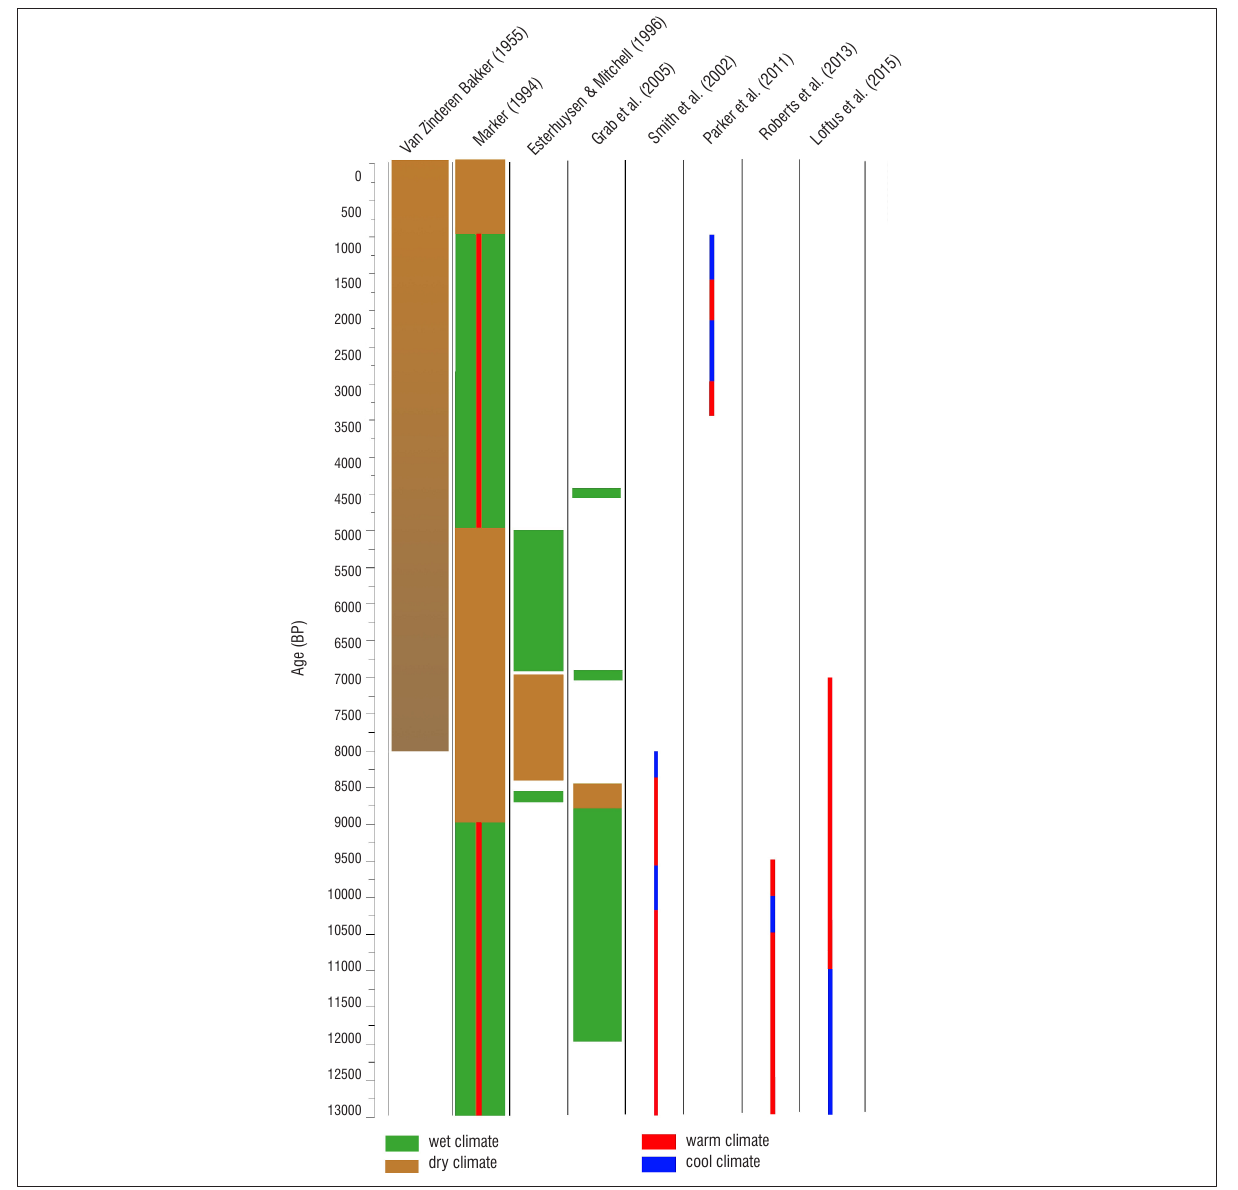
Figure 3: Palaeoclimatic inferences based on geomorphological, archaeological and palaeobiological studies in Lesotho from 13 000 cal yr BP to present. Graduated colour represents progressive